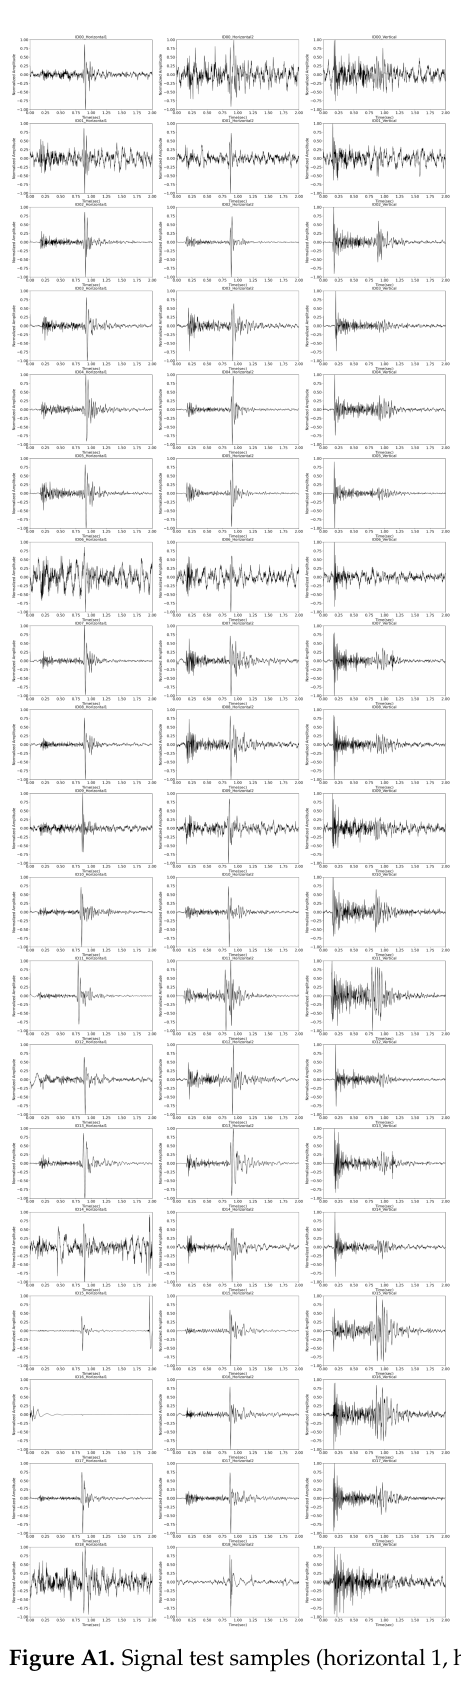
Figure A1. Signal test samples (horizontal 1, horizontal 2, and